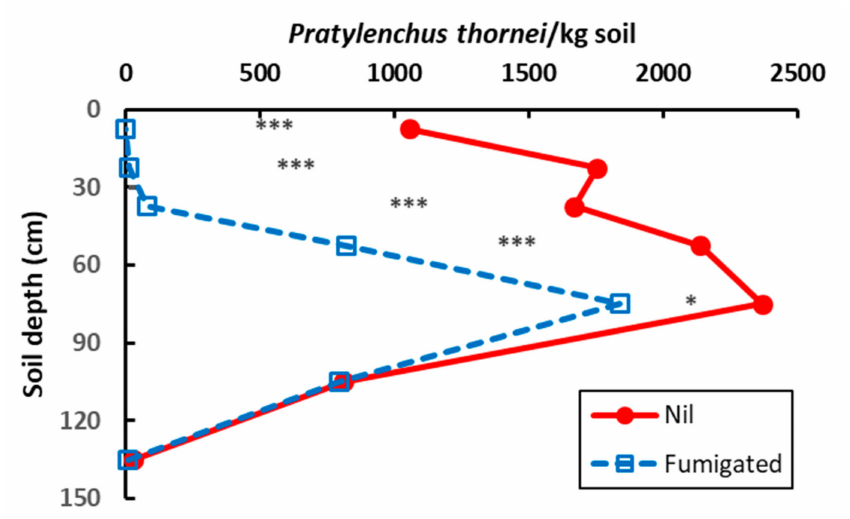
Figure 5. Effects of fumigation with methyl bromide on population density of Pratylenchus thornei in the soil profile before sowing Experiment 3. Points are the back-transformed values from means of ln (x + 1) transformations ( n = 15), where significant differences between transformed means for nil and fumigated treatments at the respective depth intervals are indicated as * = p < 0.05 and *** = p < 0.001.